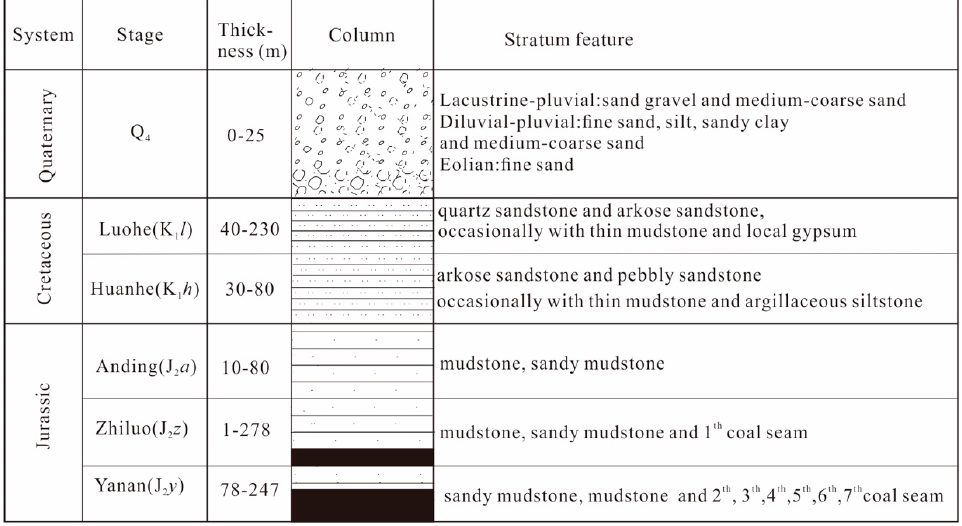
Figure 2. Stratigraphic column of the study area.